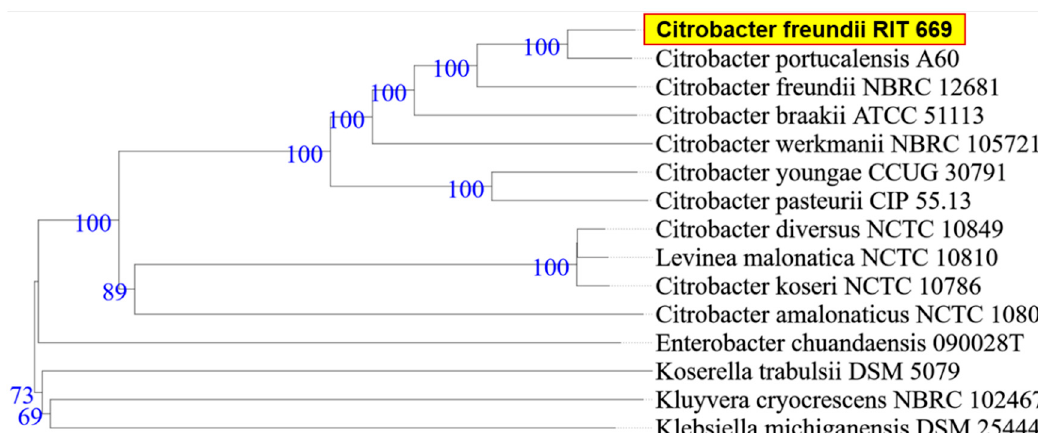
Figure 2. WGS ‐ based phylogenetic tree using TYGS for C. freundii RIT669. TYGS infers trees with FastME 2.1.4 [103] based on Genome BLAST Distance Phylogeny (GBDP) distances calculated from the genome sequences, whereas branch lengths are scaled in terms of GBDP distance formula d5 [107]. Numbers above branches are GBDP pseudo ‐ bootstrap support values from 100 replications.